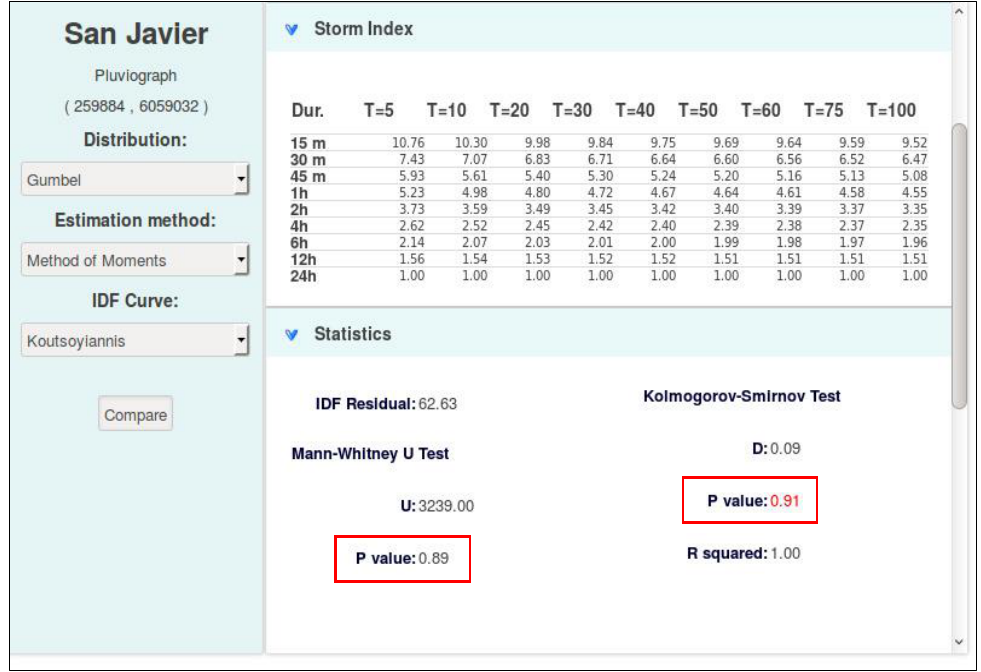
Figure 10. Storm index (S I ) calculated for each duration and return period of a pluviographic gauge (Talca City) included in WEBSE IDF . The results of the goodness of fit represent the modeled rainfall intensity, because of the combination between any selected PDF and IDF model. As the p values in the red boxes are larger than the α-level (α = 0.1), the Gumbel PDF is accepted for San Javier.